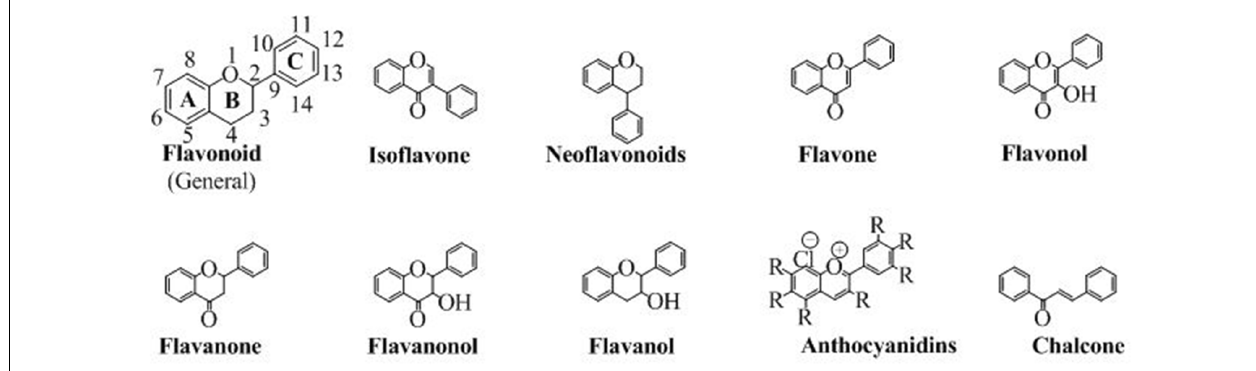
FIGURE 2 | The chemical structures of major classes of flavonoids.